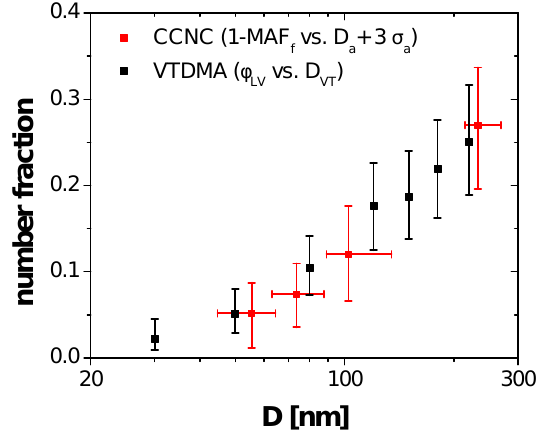
Fig. 5. Black symbols: number fraction of particles with low volatility ( φ LV ) plotted versus the particle size selected by the VT- DMA ( D VT ). Red symbols: number fraction of particles that are not CCN-active within the investigated size range (1–MAF f ) plot- ted versus the smallest particle size at which the CCN spectrum reaches MAF f ( D a + 3 σ a ); each symbol stands for each supersatu- ration. Symbols are median values throughout the campaign, error bars extend to lower and upper quartiles.